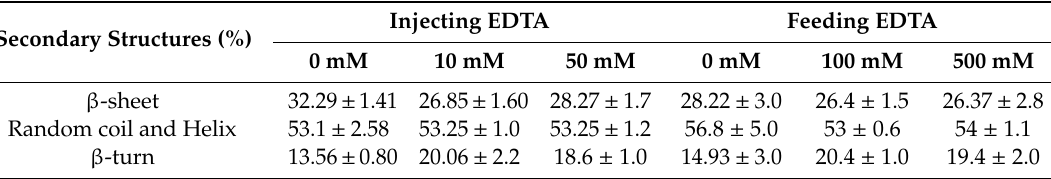
Table 1. Averaged percentages of secondary structures of silk fiber after EDTA injection and feeding.